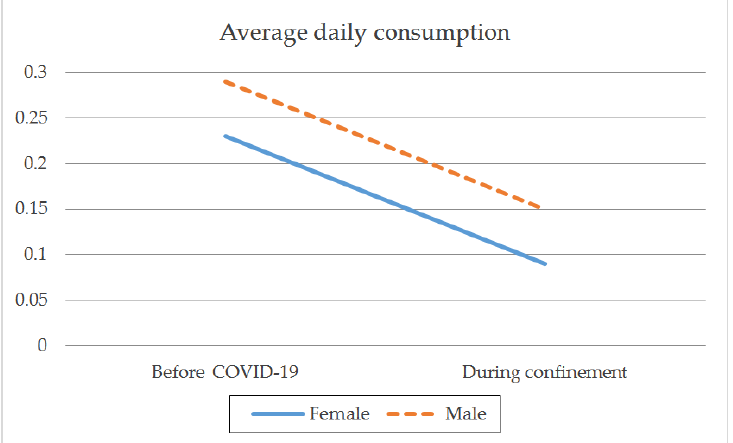
Figure 2. Average daily alcohol consumption by gender before the pandemic and during COVID-19 confinement.